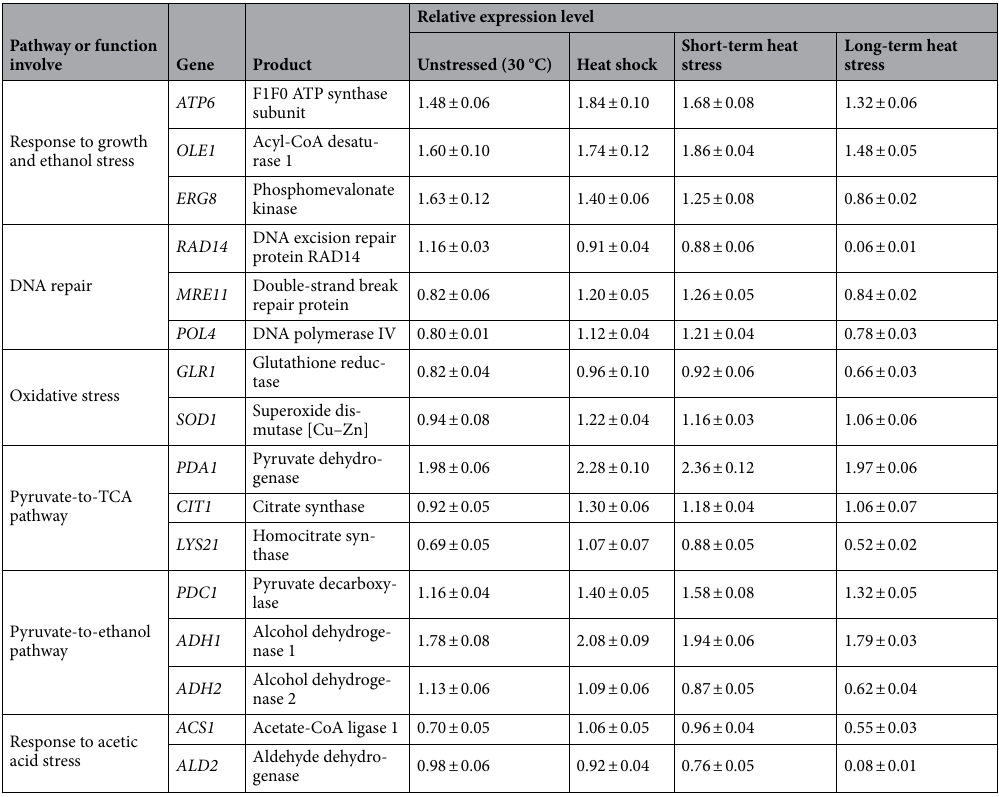
Table 11. Expression level of genes in the thermotolerant yeast S. cerevisiae HG1.1 during high-temperature ethanol fermentation using RT-qPCR.